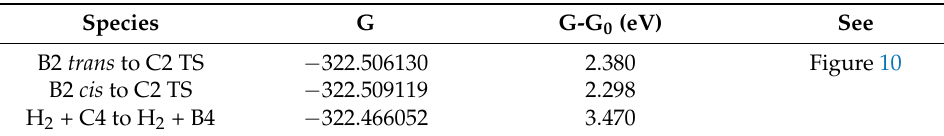
Figure 10. Transformation ( a ) between cis B2 and C2 and ( b ) between trans B2 and C2. Table 3. Energetics for C–B crossover.